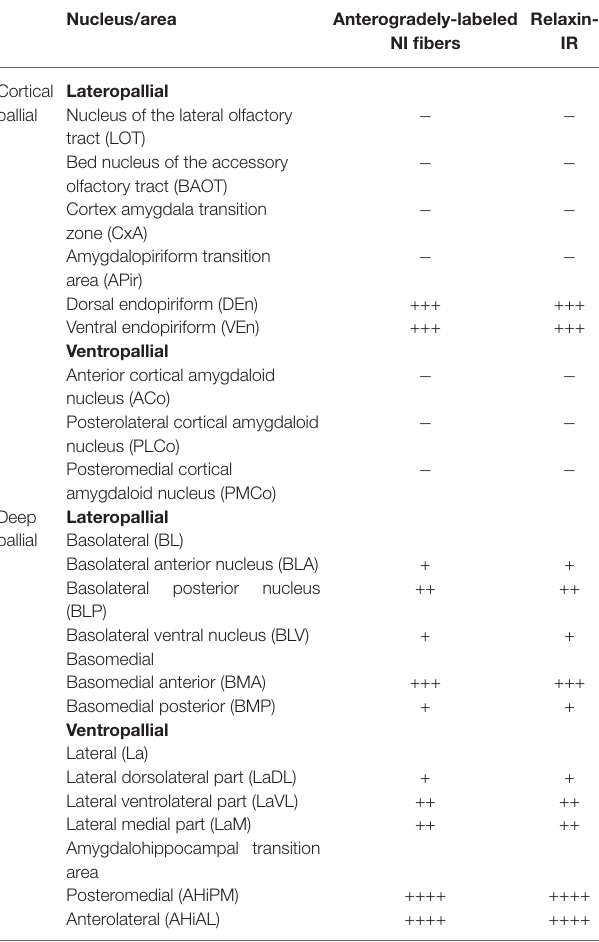
TABLE 1 | Distribution of anterogradely-labeled nucleus incertus (NI) fibers and relaxin-3-positive fibers in pallial nuclei of amygdala . Nucleus/area